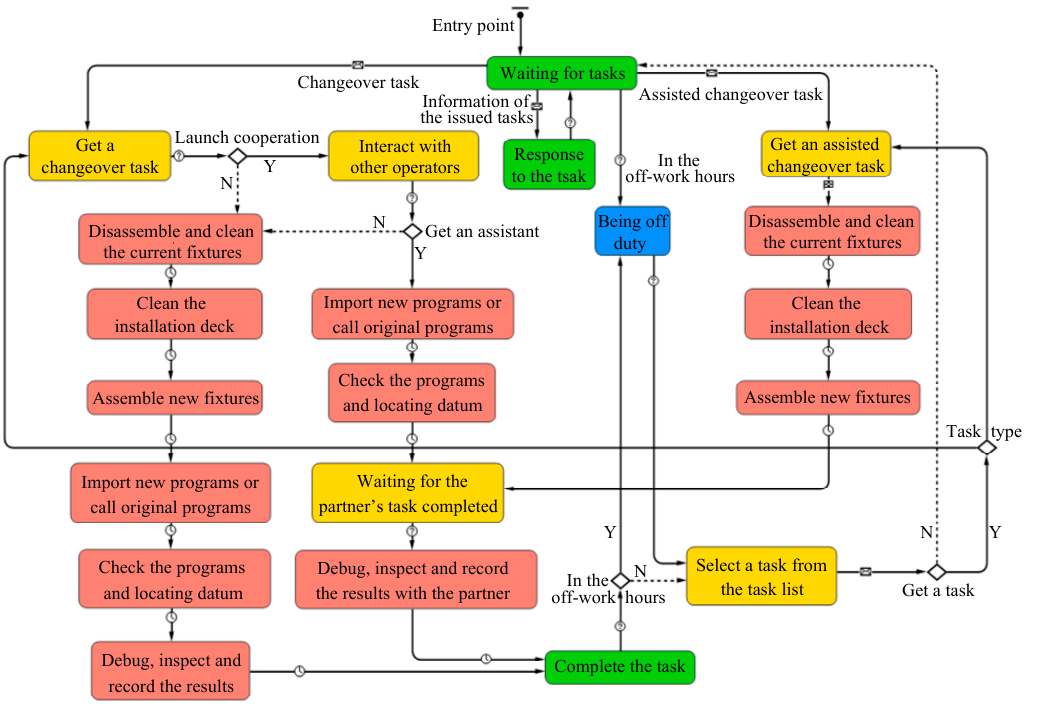
Figure 3. State chart of operator agents’ changeover behavior.